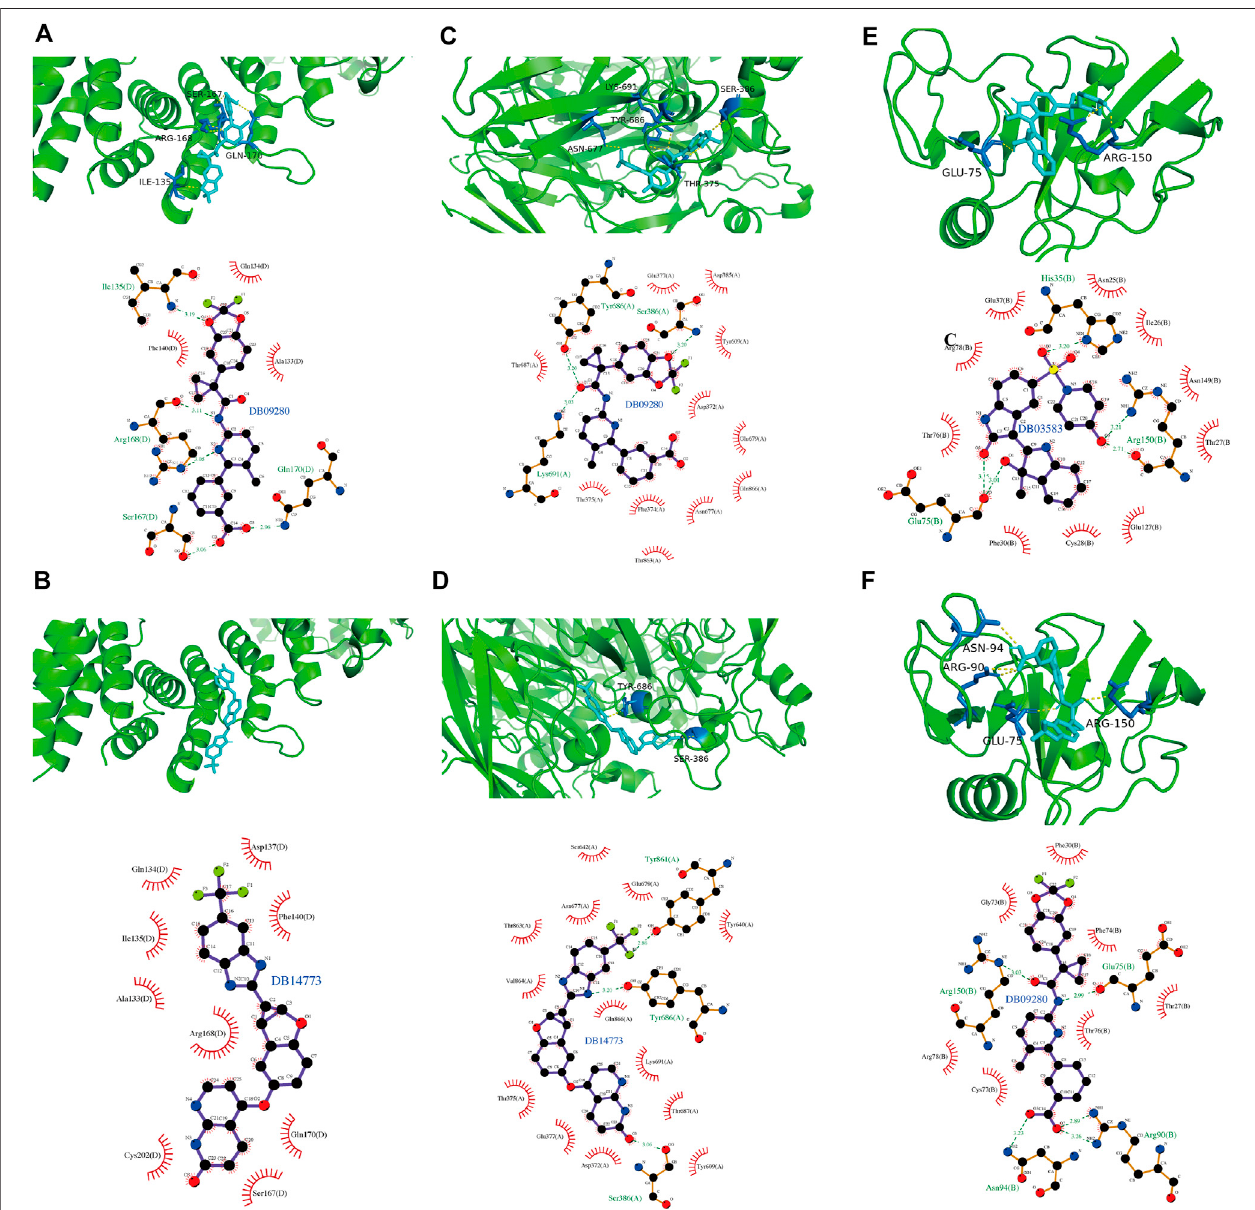
FIGURE14| ThedockingconformationandinteractionforceanalysisofCAPG,CPandCD44withtheirdockedcompounds.Analysisofthedockingconformation andinteractionforcesofCAPGwithDB09280andDB14773 (A,B) ,ofCPwithDB09280andDB14773 (C,D) andofCD44withDB03583andDB09280 (E,F) .Tophalf: PyMol shows docking conformation and hydrogen bonding with the color symbols of cyan for small molecule, yellow dashed line for hydrogen bonding, and blue for amino acid residues forming hydrogen bond with small molecule. Bottom half: Ligplus force analysis, small molecule in the middle, surrounded by related protein amino acid residues, green dashed line representing for hydrogen bonding formed, green amino acid names representing for amino acid residues forming hydrogen bond.